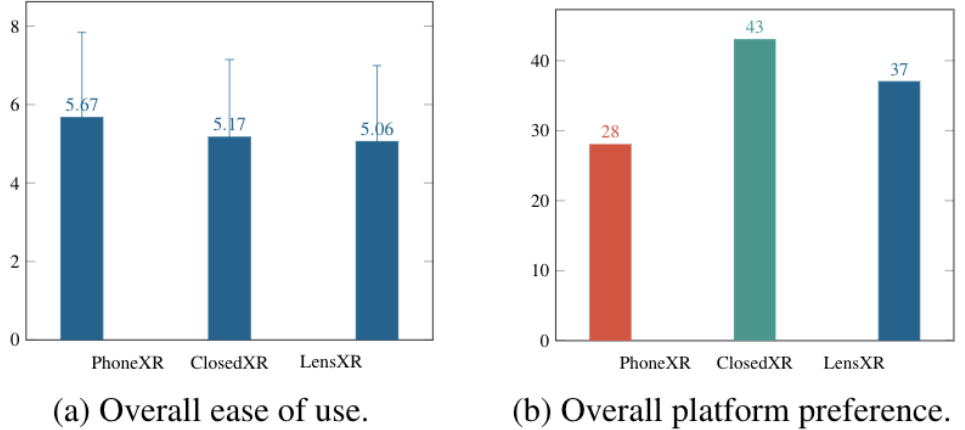
Figure 15. Survey results regarding the overall ease of multi-mode and multitasking experience and general preference. The vertical axes represent the subjective levels in the 7-point Likert scale ( a ), and the preference scores ( b